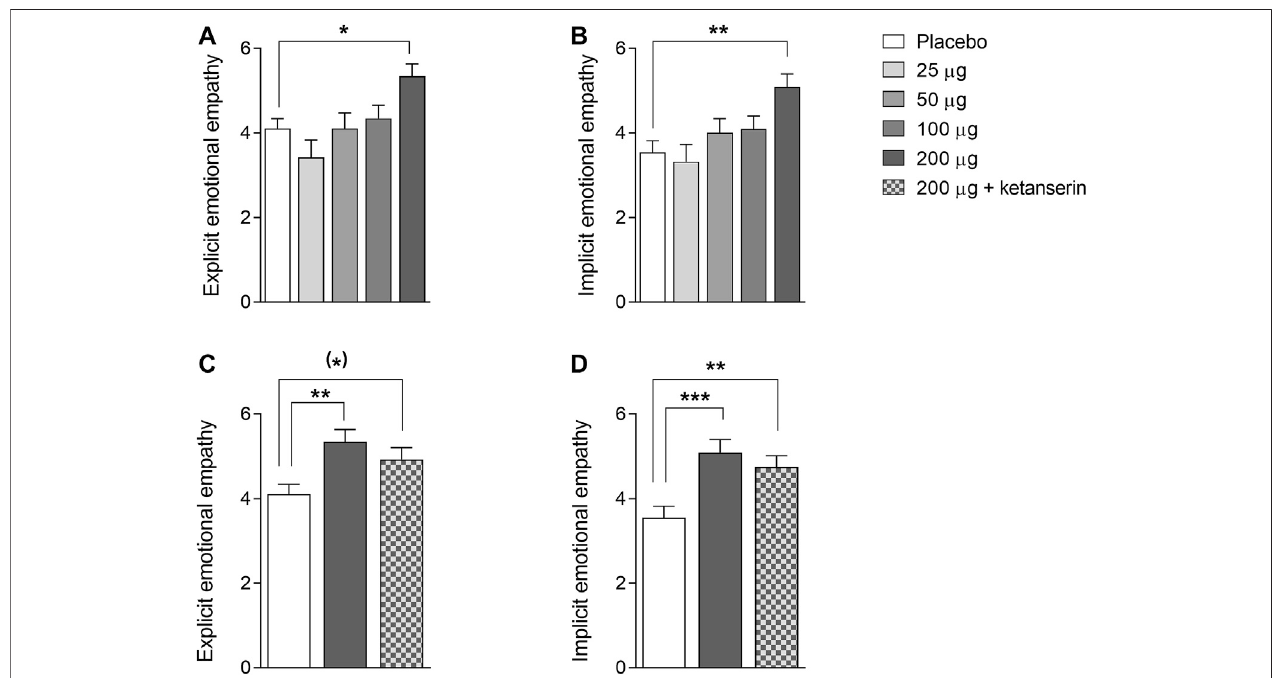
FIGURE1| Acuteeffects ofLSD onemotional empathy onthe Multifaceted Empathy Test.LSD dose-dependently increasedexplicit (A) and implicit (B) emotional empathycomparedwithplacebo,withthe200 µgLSDdoseproducingsigni fi canteffects.Theincreasesinexplicit (C) andimplicit (D) empathythatwereinducedbythe 200 µgLSDdosewereonlyslightlyreducedbyketanserin pretreatmentcompared withplacebopretreatmentand remained elevated compared withplacebo.Thedata are expressed as the mean ± SEM in 16 subjects ( * ) p < 0.1, * p < 0.05, ** p < 0.01, *** p < 0.01.